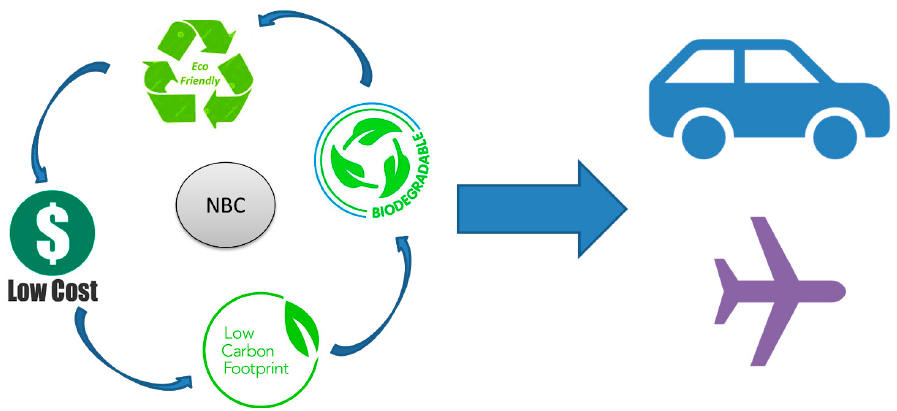
Figure 10. Sustainable features and potentiality of NBCs .